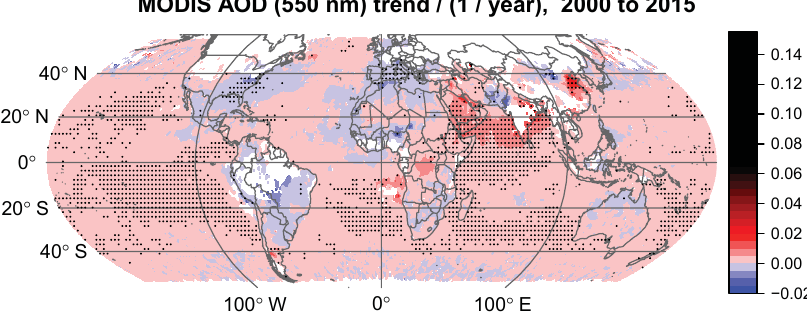
Figure 1. Global AOD trends between March 2000 and February 2015, based on the Dark Target/Deep Blue 550nm AOD from MODIS Terra, collection 6. Regions with significant trends ( p value < 0 . 01) are dotted, regions with incomplete time series are coloured white. Despite being less pronounced than for the period January 2001 to December 2010 considered by Pozzer et al. (2015) (see also Fig. S1 in the Supplement), the Middle East is a hot spot of AOD increase. Comparable trends are only found in China. An exceptional trend over the Aral Sea region defines the upper limit of the colour scale, but is likely predominantly attributed to retrieval artefacts (see the discussion in the Supplement).